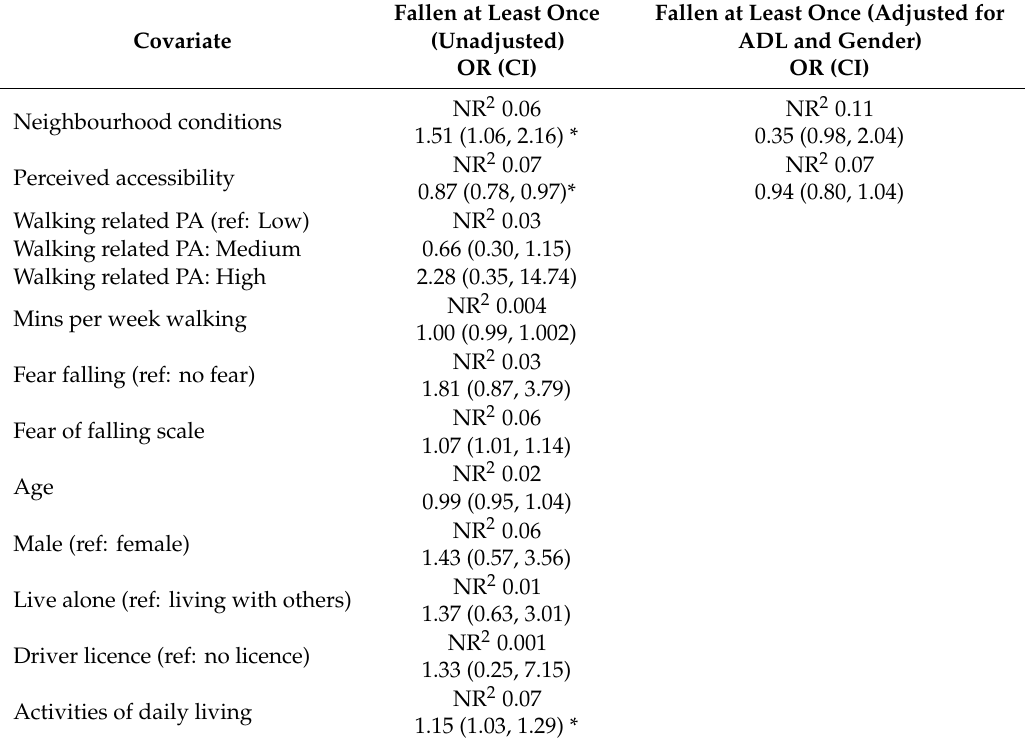
Table 2. Logistic regression models—odds ratios (OR) demonstrate the odds of having fallen in the past 12 months for each key variable. Covariate Neighbourhood conditions Perceived accessibility